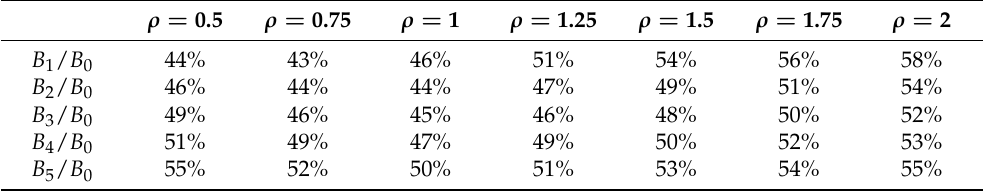
Table 4. Burst ratio B i as a percentage of B 0 for different values of the system